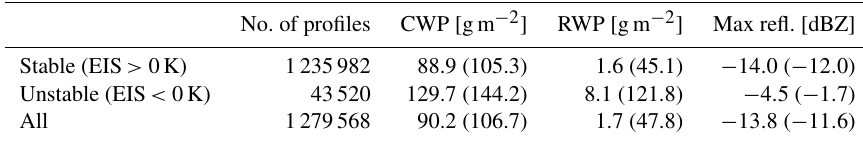
Table 3. Summary of CWP and RSP statistics from the joint APR-3 and RSP joint retrieval algorithm. Values of CWP, RWP, and maximum reflectivity are reported as median values (mean values in parentheses).